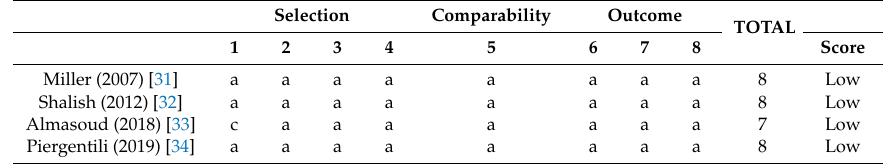
Figure 2. RoB2 assessment. R—bias arising from the randomization process; D—bias due to deviations from intended interventions; Mi—bias due to missing outcome data; Me—bias in measurement of the outcome; S—bias in selection of the reported result; O—overall risk of bias. Table 2. NOS (Newcastle–Ottawa Scale) score for case–control